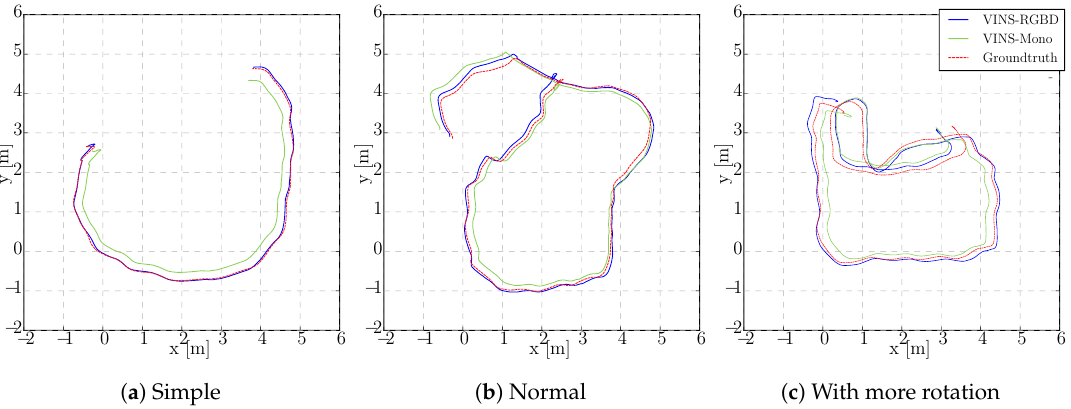
Figure 10. Handheld trajectory estimation.